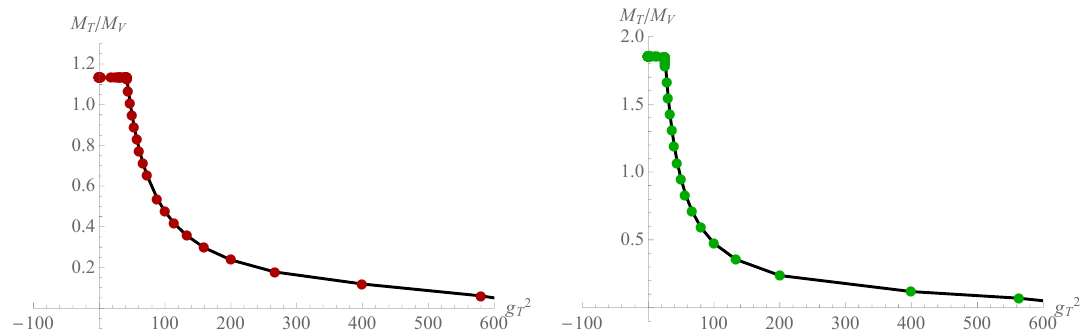
Figure 13. AdS/ Sp(4) 4 F, 6 A 2 — We show the effect of adding the double-trace operator eq. (4.15) to the spin- 1 / 2 baryon’s mass. On the left we use the L 0 ( ρ ) from the F representation and on the right L 0 ( ρ ) from the A 2 representation. Note the initial linear behaviour when g 2 but then as it passes a critical value the effect on the mass is much larger.